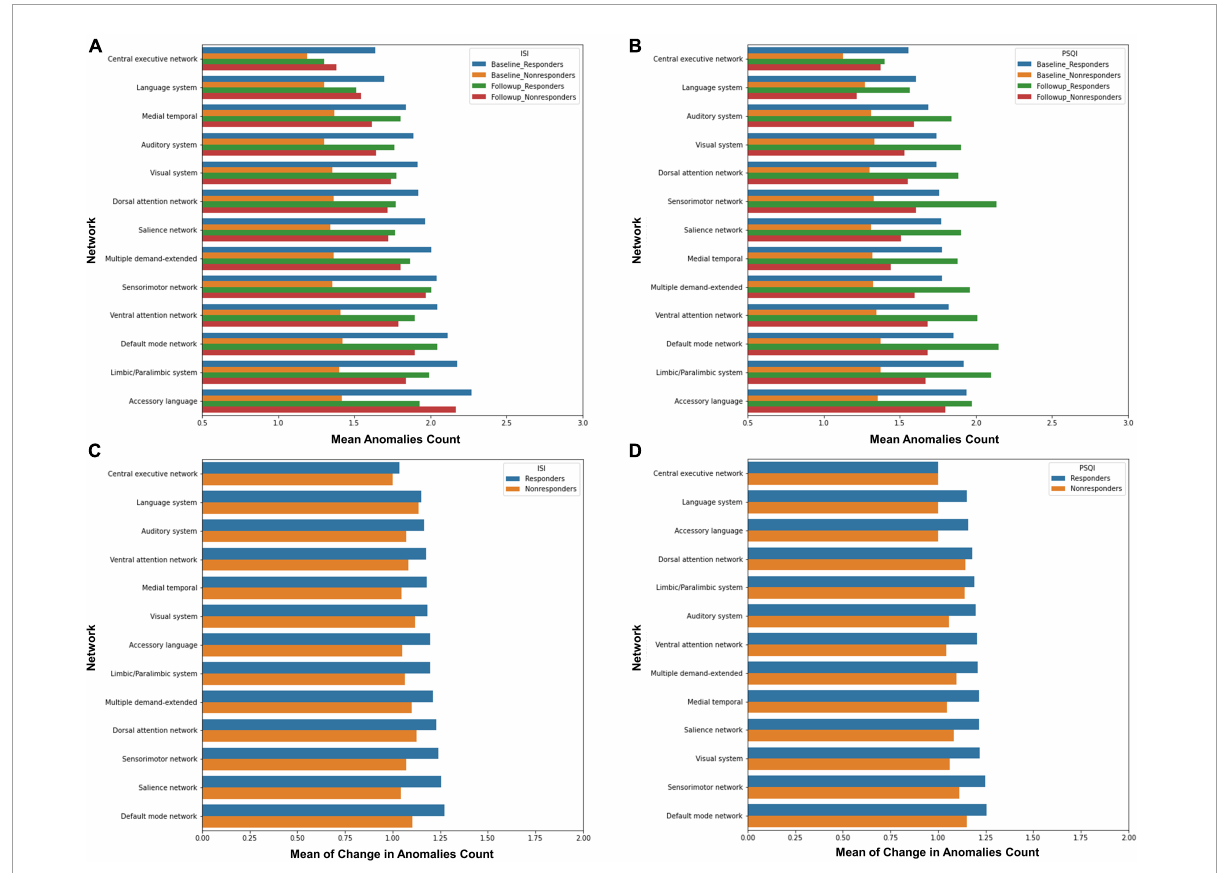
FIGURE2 Median absolute deviation anomaly detection. Each graph depicts the mean anomaly count at baseline and follow-up for each network when response was measured using (A) the ISI, and, (B) the PSQI. The mean of the change in anomaly counts from baseline to follow-up in responders and non-responders have also been graphed for (C) the ISI, and, (D) the